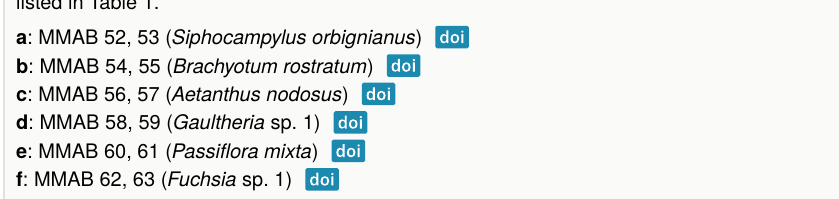
Diversity of putatively bird pollinated plants of the Manú Gradient. MMAB collection numbers listed in Table